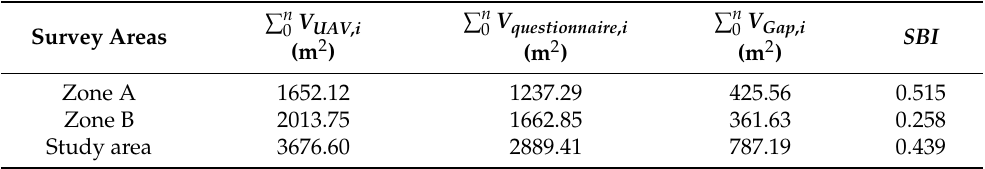
Table 3. Survey bias index ( SBI ) of rural homestead survey in the questionnaire and UAV. V UAV is the area of a rural homestead obtained by the UAV (m 2 ), V questionnaire is the area of a rural homestead obtained by the self-reported questionnaire (m 2 ), and n is the number of rural homesteads surveyed (12 and 19 in Zones A and B,